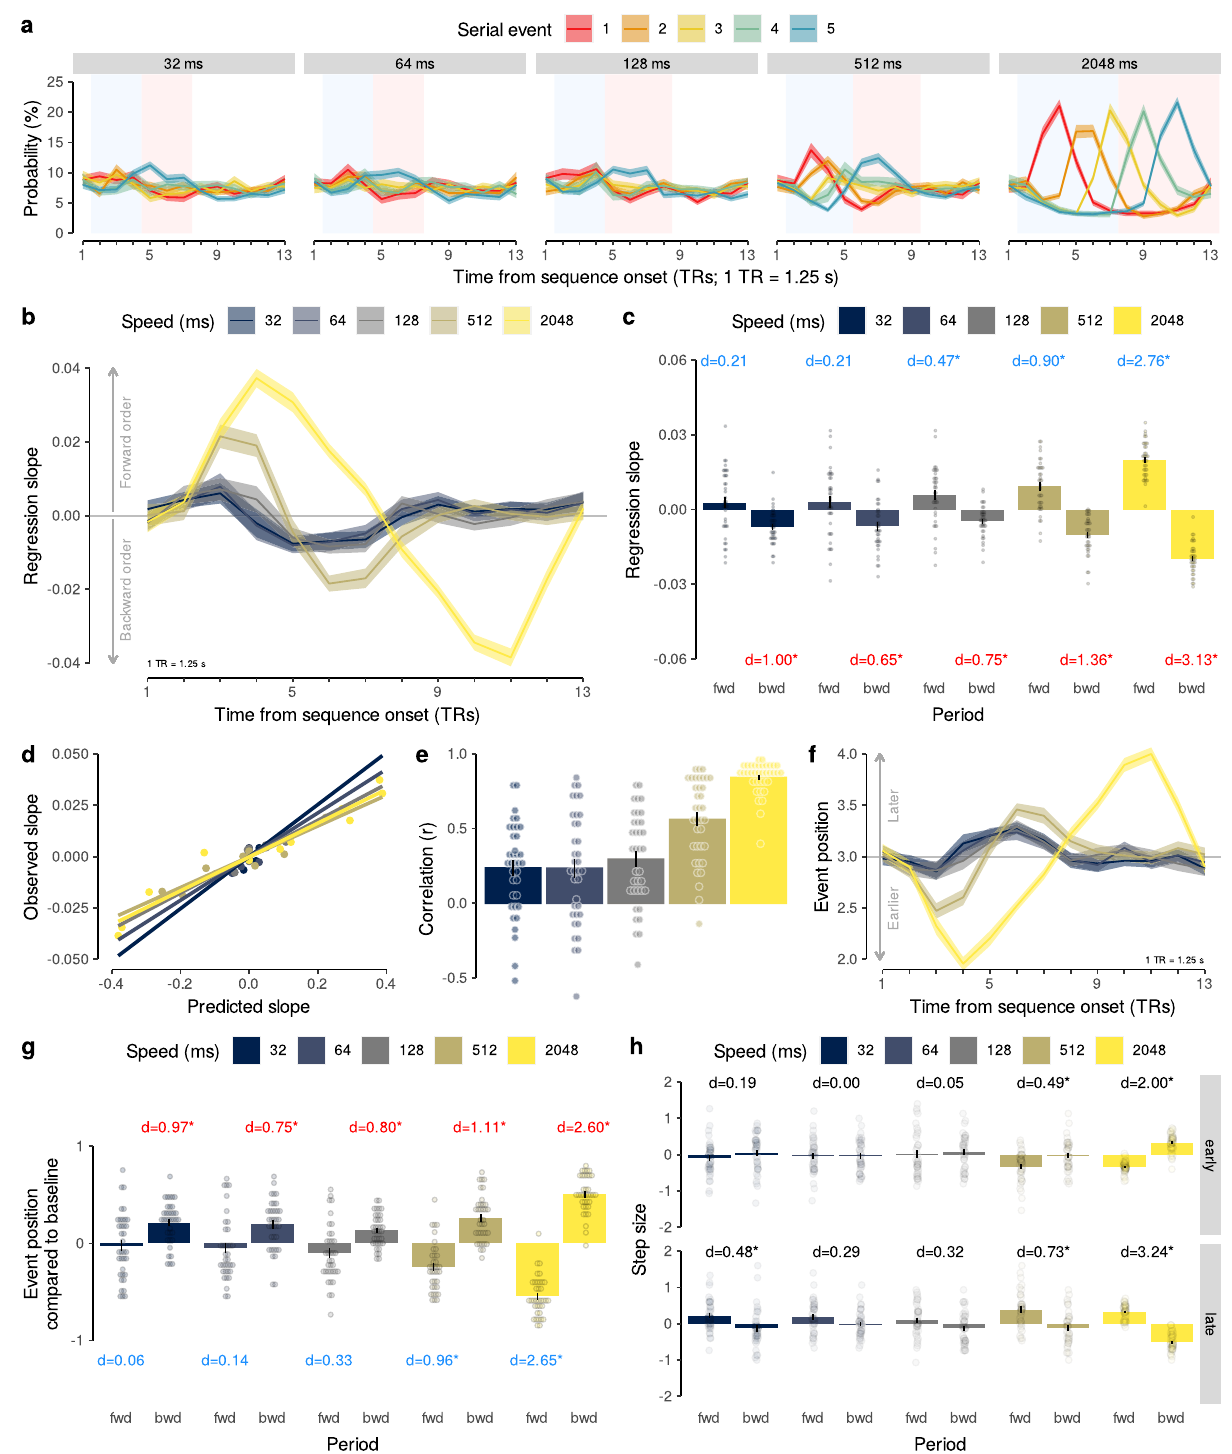
Next, we investigated evidence of pattern sequentiality across successive measurements, similar to Schuck and Niv 54 . Speci fi - cally, for each TR we only considered the decoded image with the highest probability and asked whether earlier images were decoded primarily in earlier TRs, and whether later images were primarily decoded in later TRs. In line with this prediction, the average serial position fl uctuated in a similar manner as the regression coef fi cients, with a tendency of early positions to be decoded in early TRs, and later positions in later TRs (Fig. 3f).